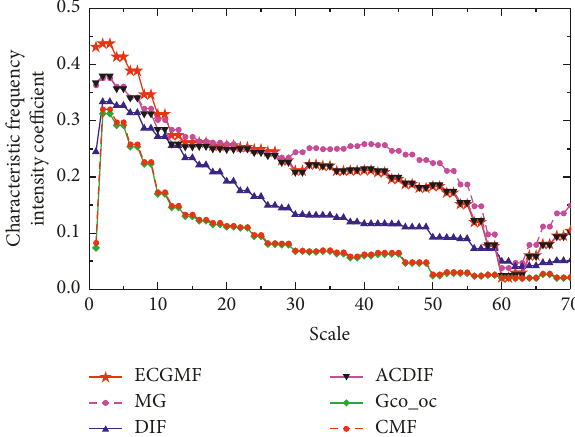
Figure 3: Characteristic frequency intensity coefficients of ECGMF, MG, DIF, ACDIF, G CO-OC , and